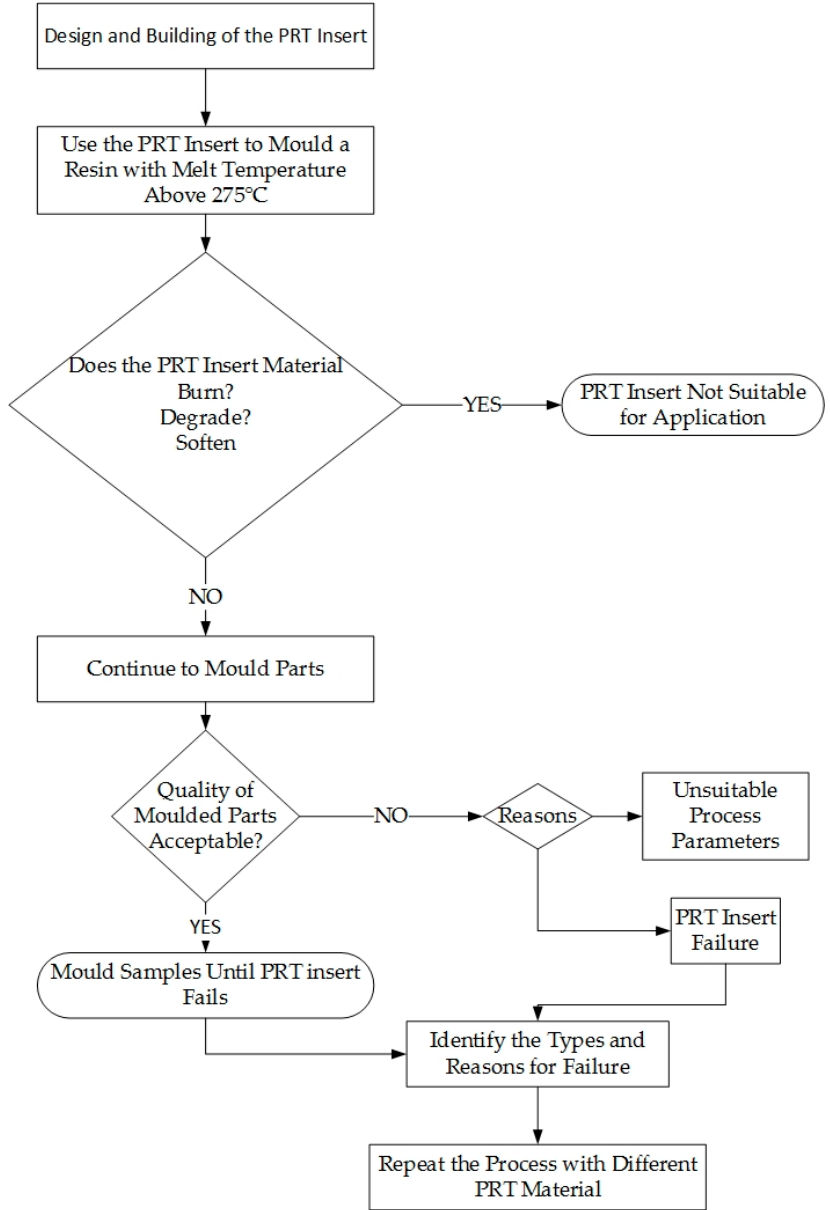
Figure 2. Process workflow.